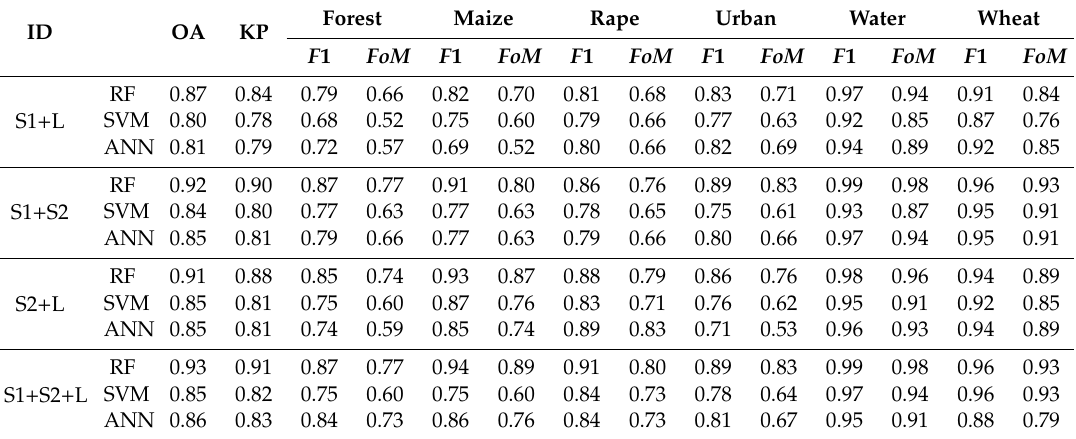
Table 7. OA, Kappa, and F 1 values for the composite S1, S2, and L data with three classifiers. FoM : Figure of Merit.